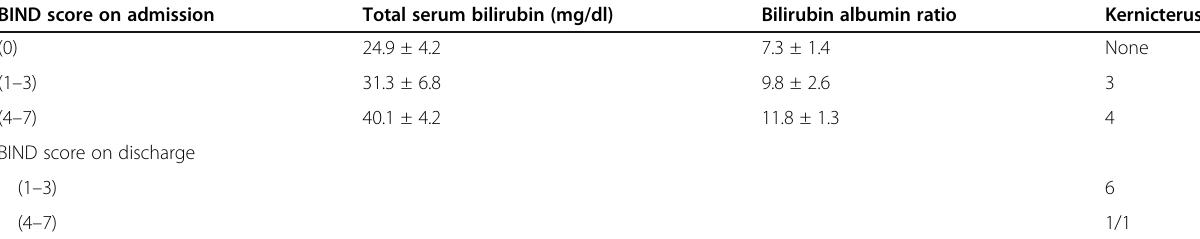
Table 3 BIND score, serum bilirubin, and bilirubin albumin ratio